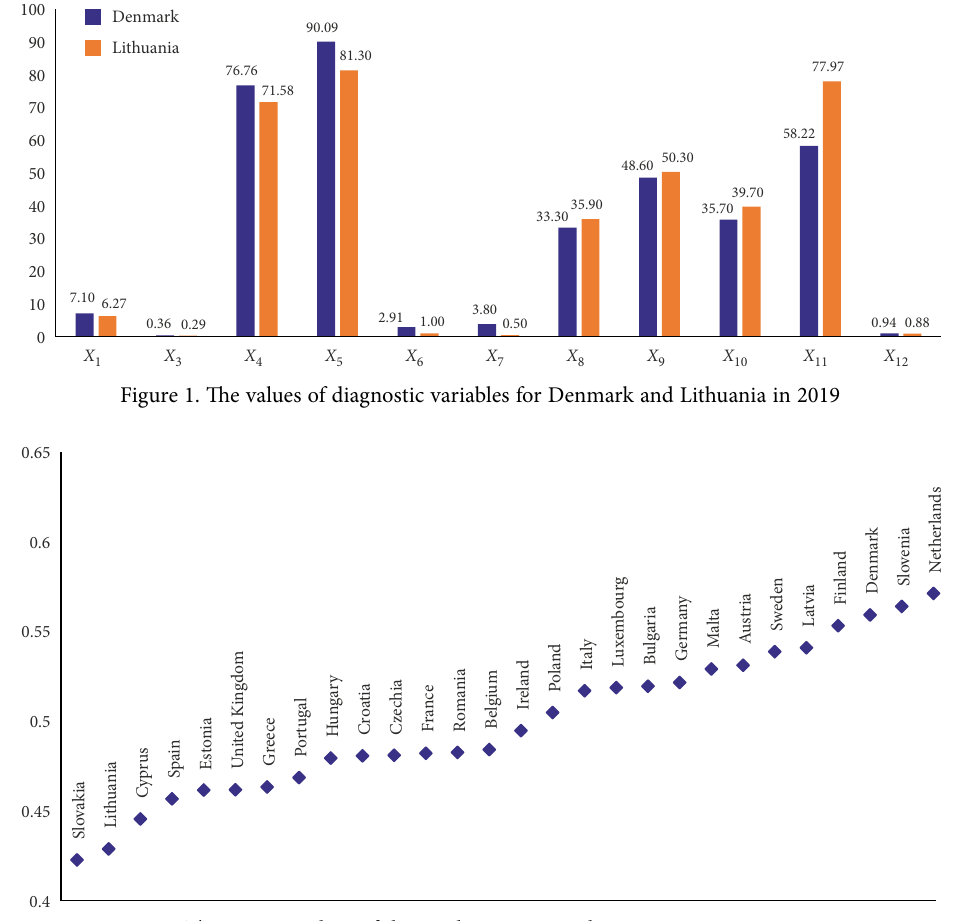
Figure 2. The average values of the synthetic measure by EU countries in